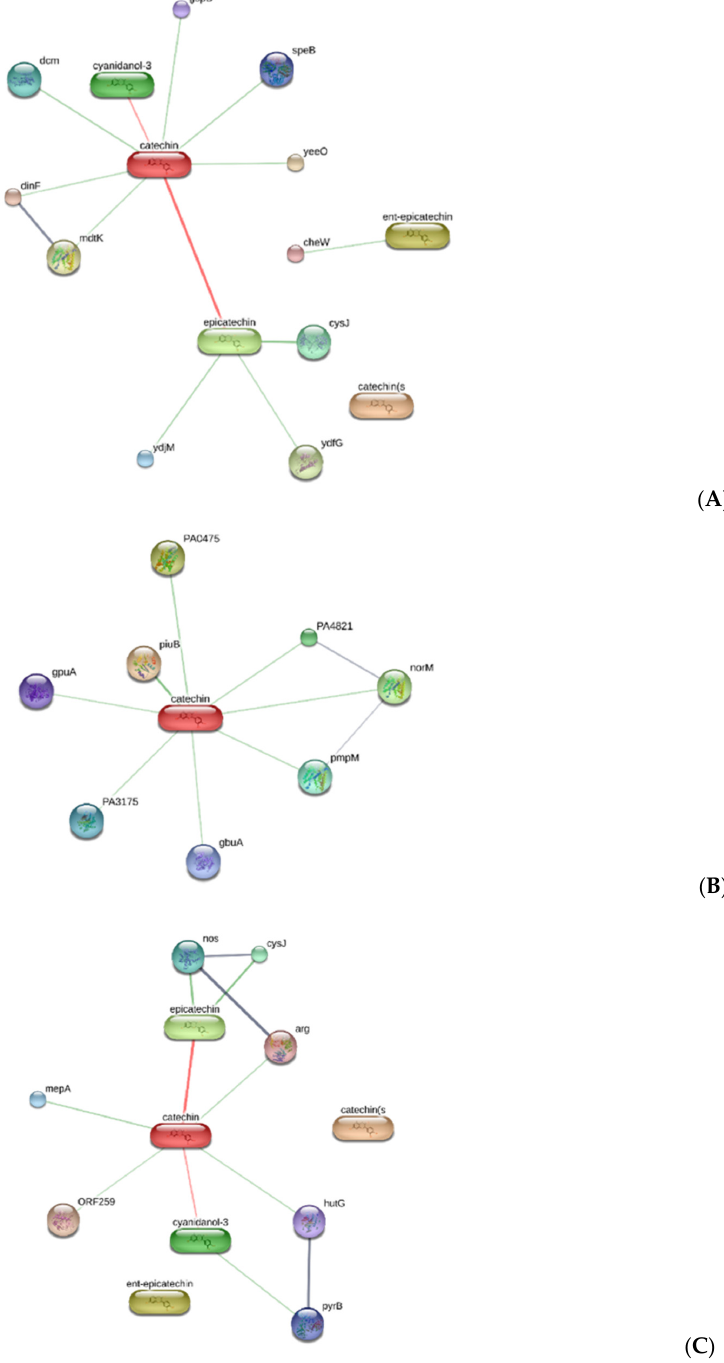
Figure 3. Component-target analysis underlying putative microbial proteins targeted by catechin, including the multidrug efflux system transporters of ( A ) E. coli (mdtK) and ( B ) P. aeruginosa (pmpM), and ( C ) S. aureus β -lactamase (ORF259).